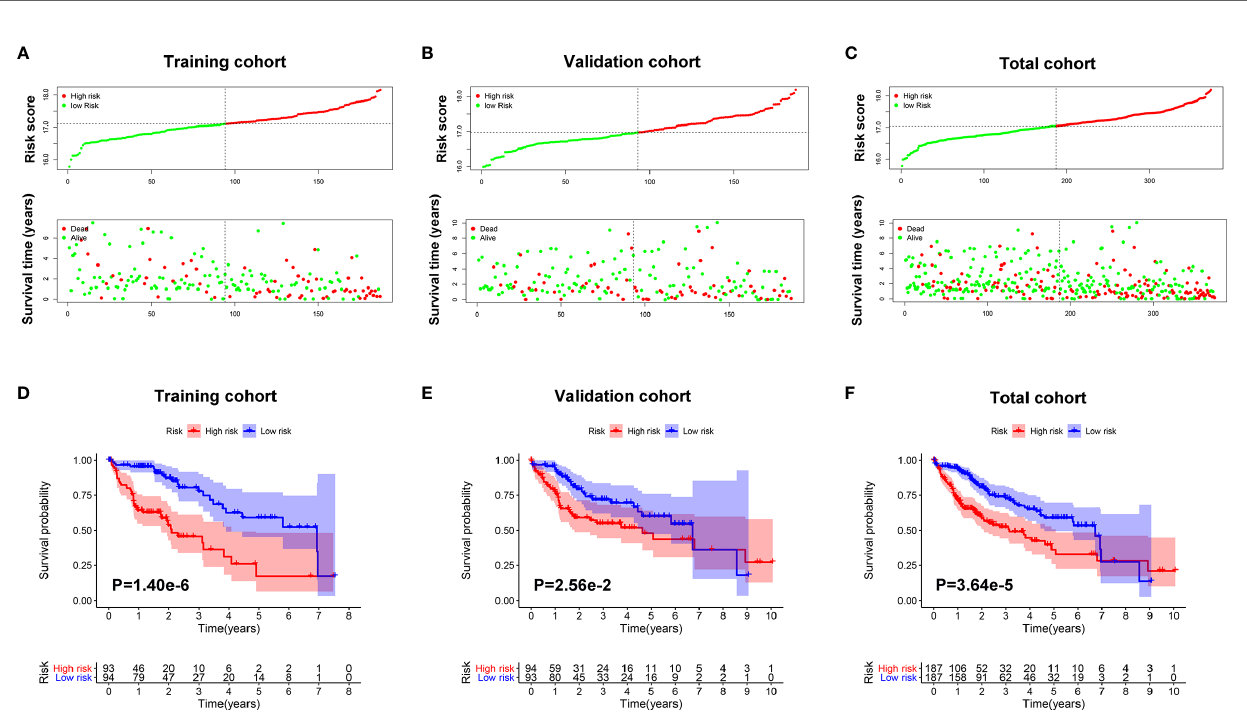
FIGURE 4 | The prognostic value of the Mito-RGs-based classi fi er. The distribution of patients ’ risk scores, survival states of the patients in the high- and low-risk groups from the training (A) , validation (B) , and total (C) cohorts. Kaplan – Meier survival analysis of overall survival between the high- and low-risk patients from the training (D) , validation (E) , and total (F)